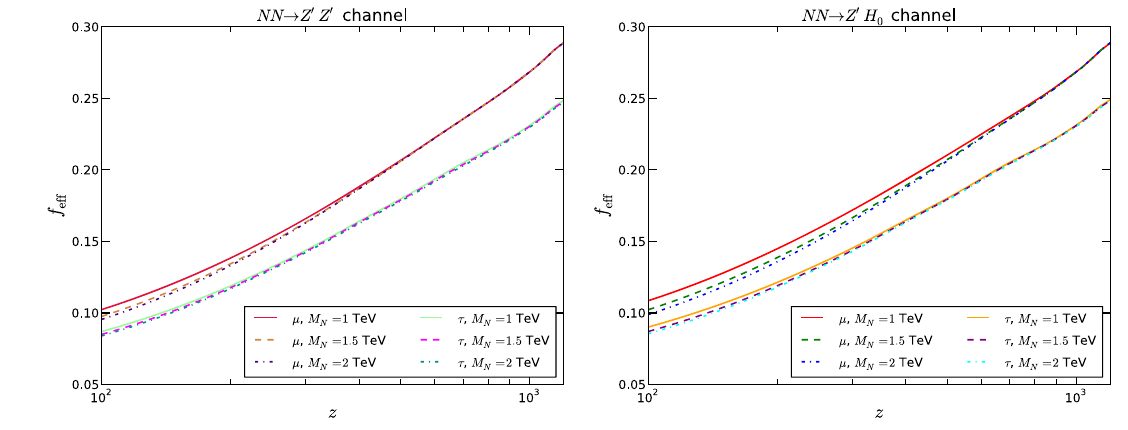
Fig. 10 f eff ( z ) curves in the range of z ∈ 100 − 1200 for benchmarks in Tables 3 (left) and 4 (right)